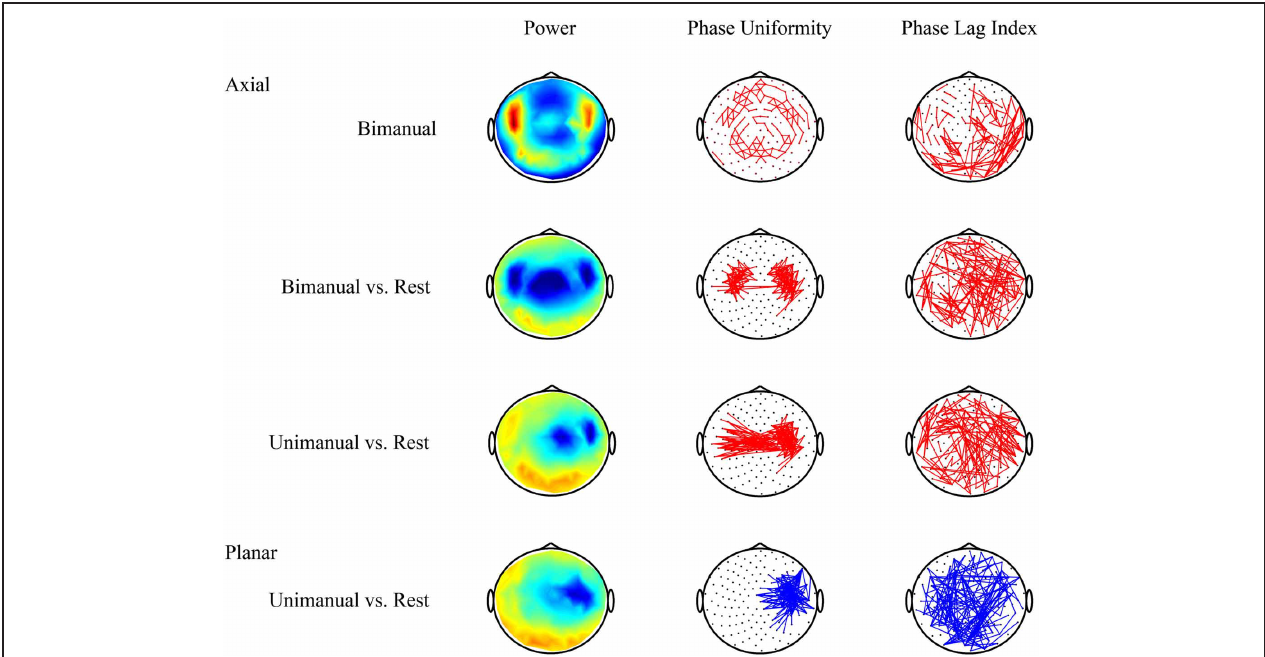
non-zero or non-pi phase difference are distributed randomly over the scalp. Hence, one cannot rule out that the increased local connectivity is caused by volume conduction. Third row : for unimanual movement there even seems to be increased interhemispheric coupling. But again it is difficult to discern whether these connections express true in-phase synchronization. Bottom row : by contrast, a transformation to planar gradients reveals a strong decrease in connectivity overlying motor areas that coincides with a drop in power. This means that, due to less beta activity, the estimated relative phase uniformity between neighboring sensors is weaker compared to resting state. Increases in power and connectivity are indicated in red, decreases in blue. Only the strongest connections are